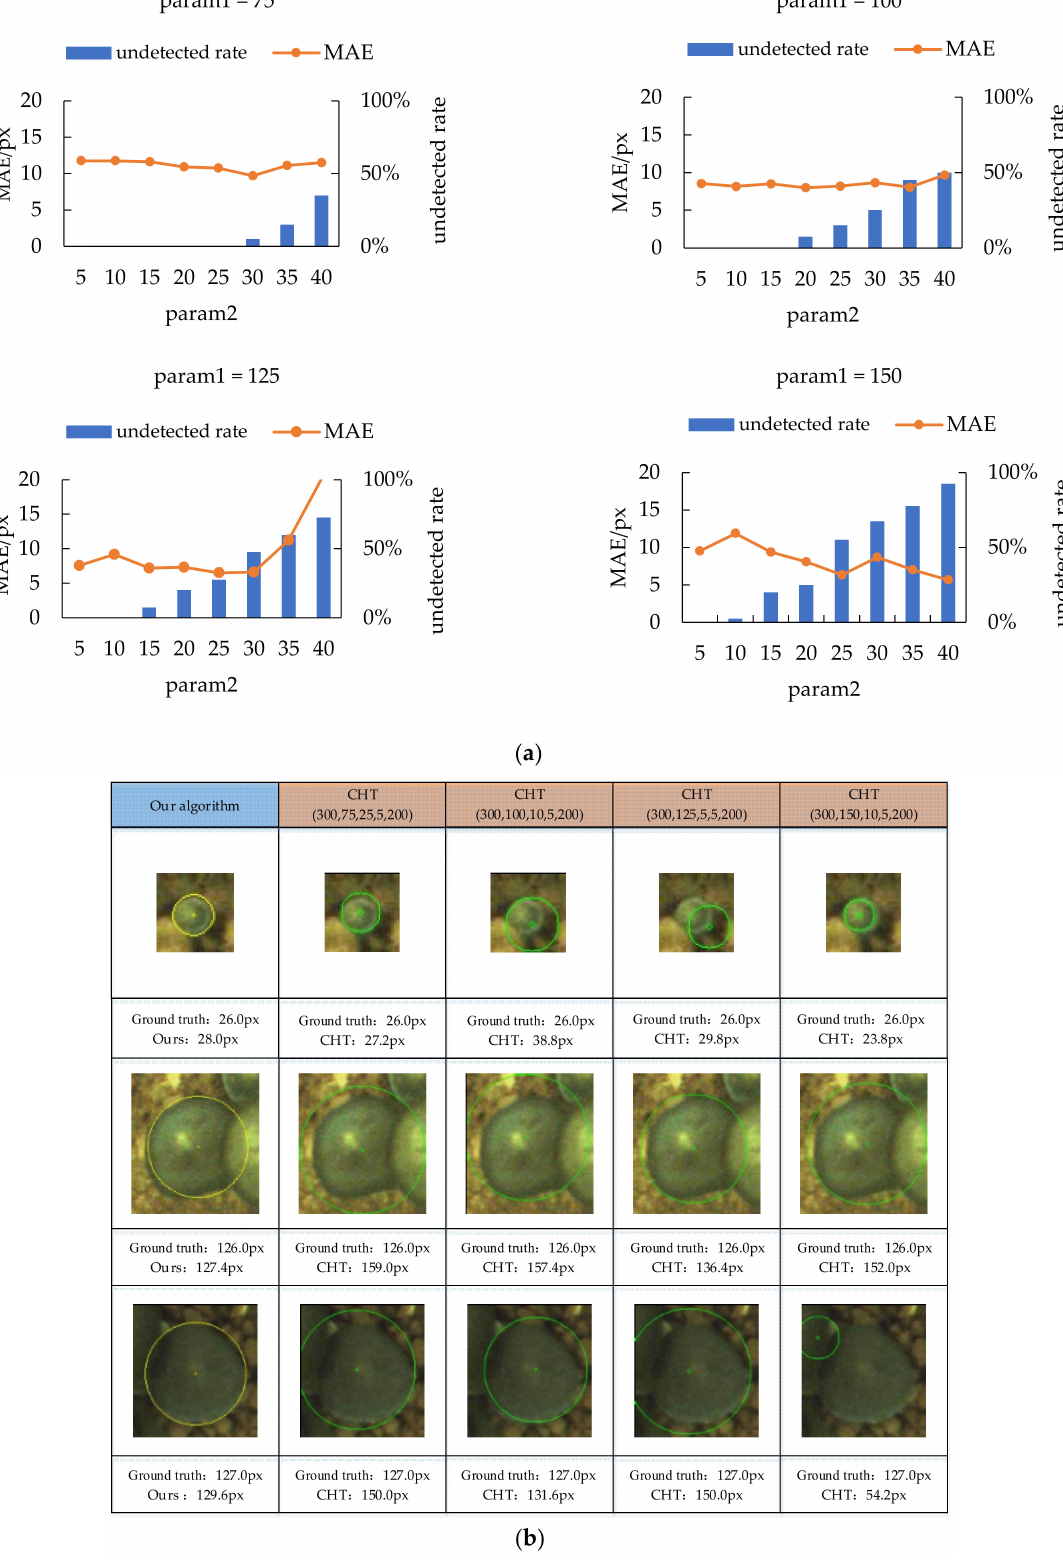
Figure 14. The comparison of CHT algorithm with different